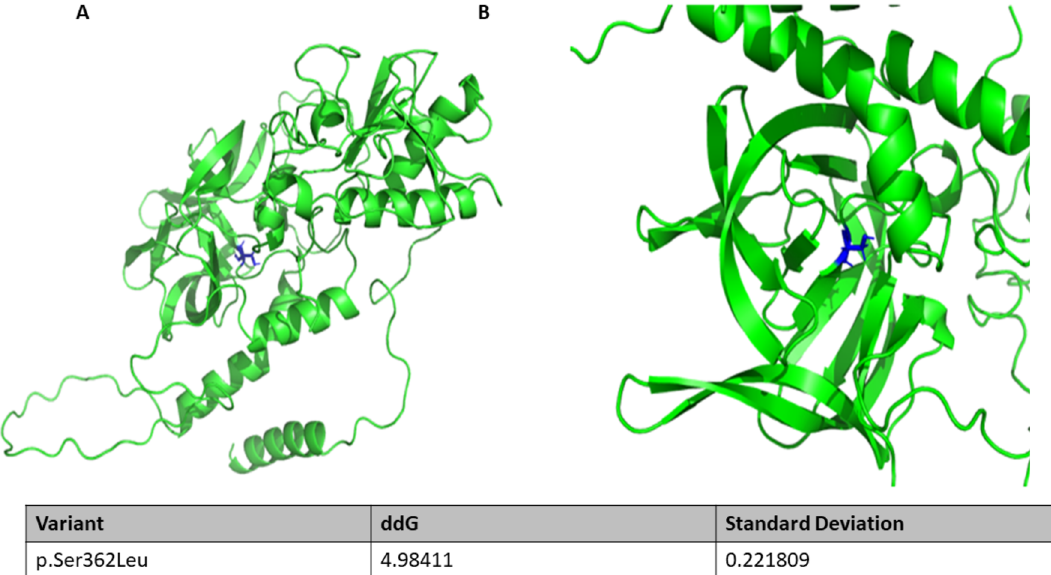
Figure 2. AlhpaFold predicted protein structures of the SHH ( A,B ). Highlighted in blue is the side-chain where the mutation occurred (( A ) closed-up view in ( B )). This is located within the Hedgehog domain that is critical for the hedgehog signaling. Table shows thermodynamic prediction of the effect of the p.Ser363Leu SHH DNM on the protein stability. The amino acid change resulted in a change in the folding free energy by 4.984 kcal/mol (± 0.221). This change is predicted to be disease causing.